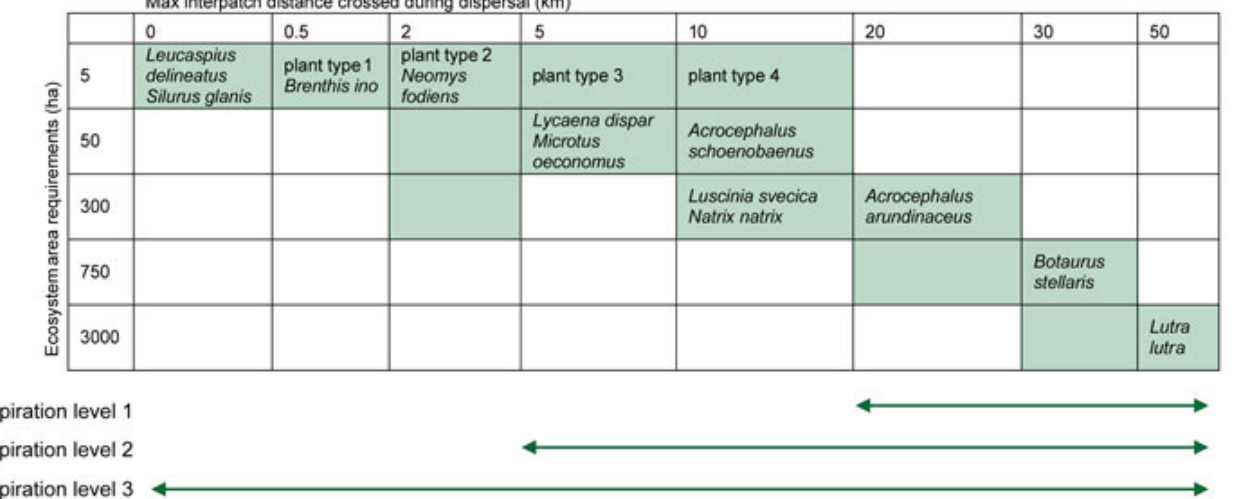
Fig. 3. Ecoprofile matrix for ecosystem type “marshland” as applied in the Robust Corridor study. All 398 target species of the Dutch Nature Conservation Policy were assigned to the cells of the matrices for seven ecosystem types. Only 15 cells were used (as indicated by gray shading). Aspiration levels are indicated by the arrows, showing different combinations of